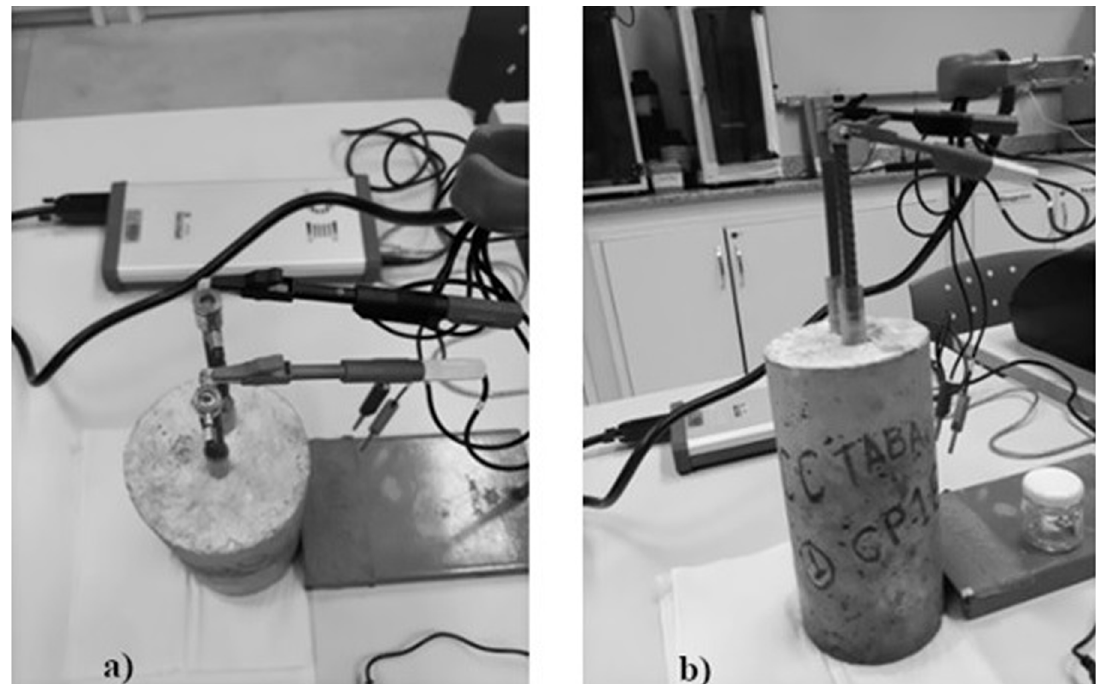
Figure 2. Electrochemical measurements - cylindrical concrete blocks, (a) upper view and (b) front